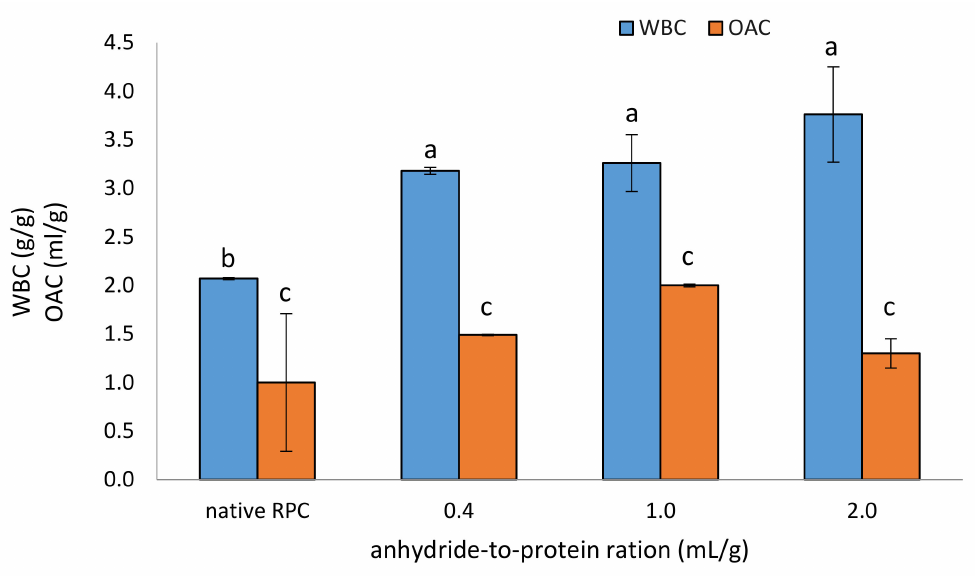
Figure 2. Effect of anhydride-to-protein ratio on water-binding capacity (WBC) and oil-absorption capacity (OAC) of native and acetylated RPC. a, b—the same letters within the WBC analysis indicate values that are not significantly different; c—the same letter within the OAC analysis indicates values that are not significantly different; RPC—rice protein concentrate; 0.4, 1.0, 2.0—rice protein preparations after acetylation conducted with different concentrations of acetic anhydride